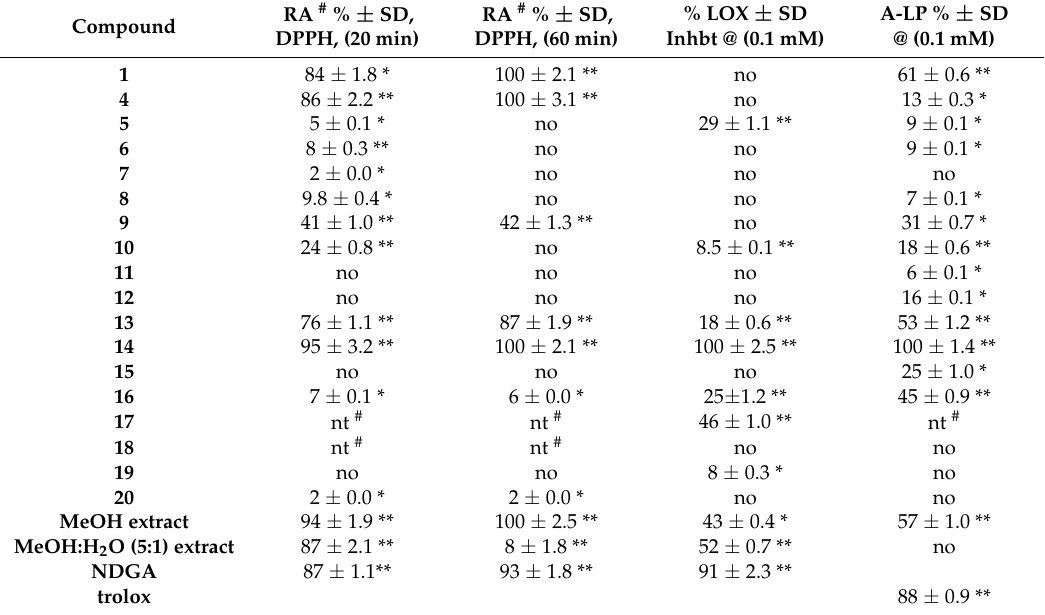
Figure 4. Percent inhibition of lipid peroxidation induced by AAPH at 0.1 mM. Table 1. In vitro reducing ability (RA %) in DPPH assay, soybean lipoxygenase inhibition (% LOX inhbt) and anti-lipid peroxidation activity (A-LP %).